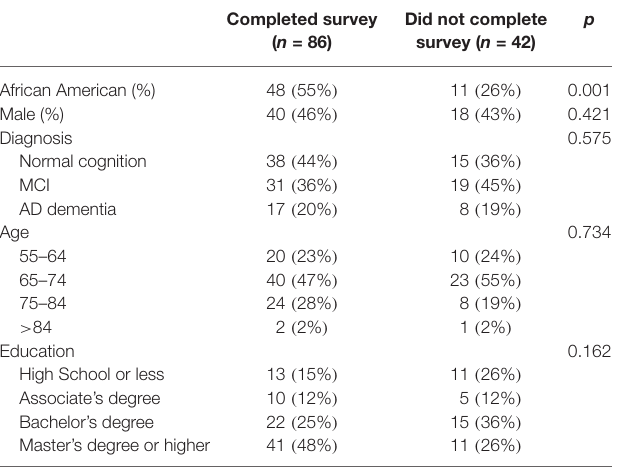
TABLE 1 | Demographic features of lumbar puncture (LP) participants who did or did not complete the pre- and post-LP surveys.